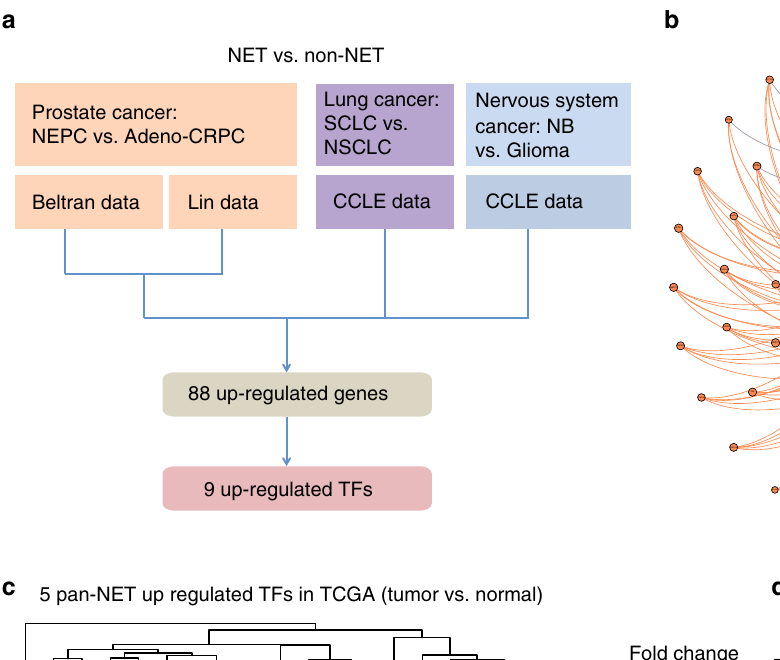
pan-NET up regulated TFs in TCGA (tumor vs.